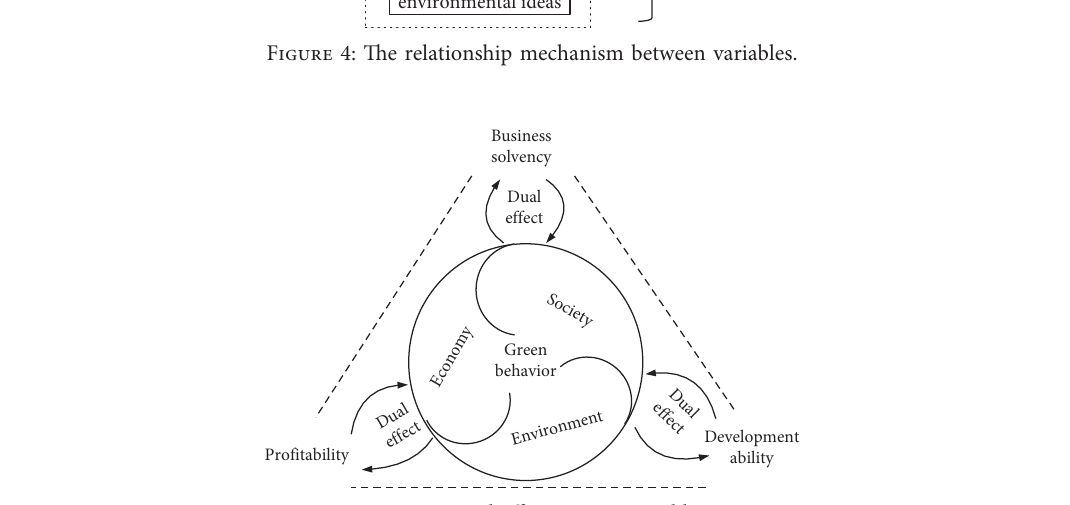
Figure 5: Dual effect among